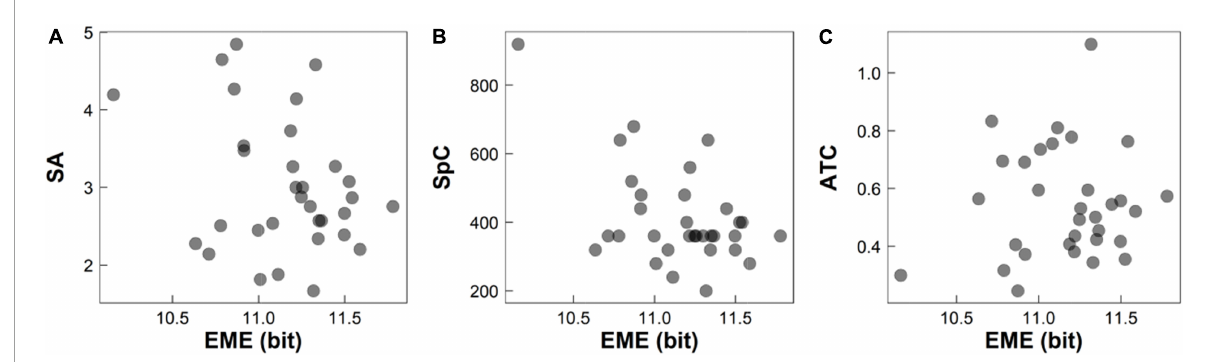
FIGURE5 Participants had the same TTN (e.g., TTN = 18 s) during RAN but had different EME, SA, SpC, and ATC: (A) EME vs. SA; (B) EME vs. SpC; and (C) EME vs. ATC. EME, eye-movement entropy; SA, selective attention; SpC, speed of cognitive processing; ATC, averaged time of circlings. TTN, total time of naming; RAN, rapid automatized